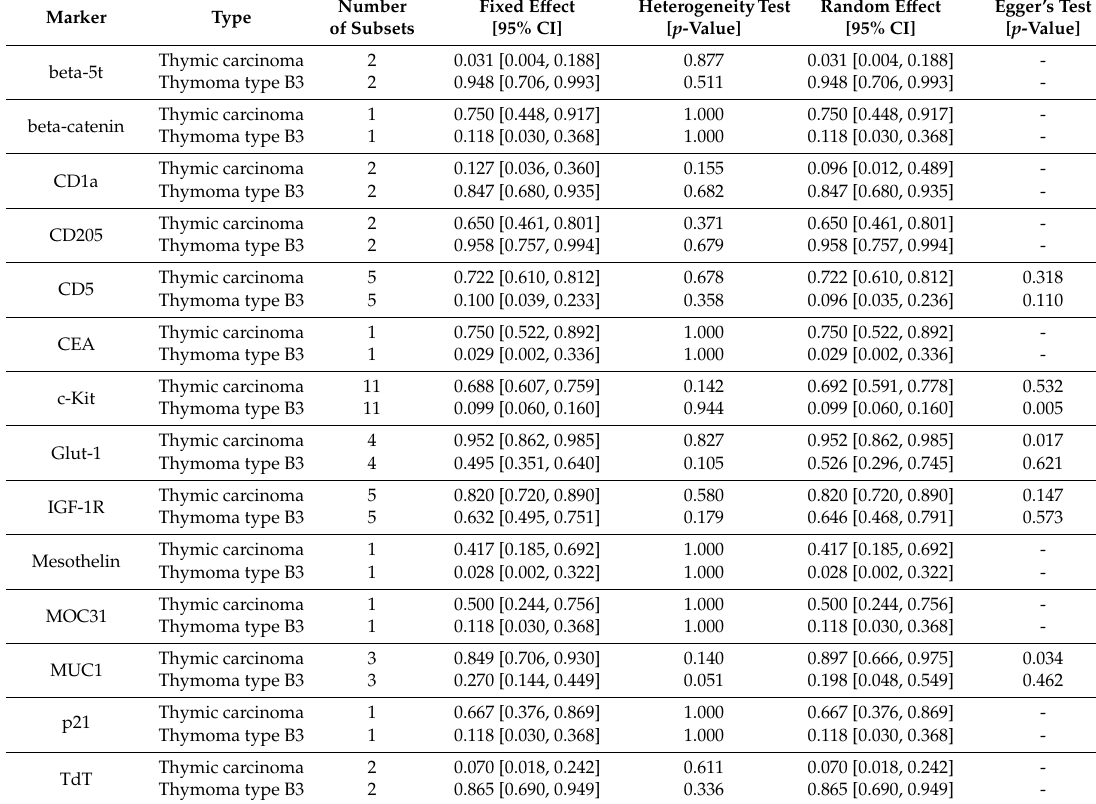
Table 3. Meta-analysis for the odds ratio of various immunohistochemical expressions between thymic carcinoma and thymoma type